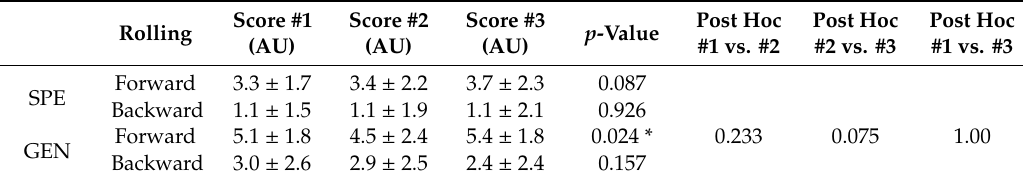
Table 1. Intra-rater reliability of the InfoSAS.